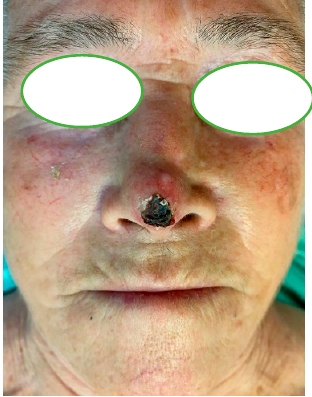
Figure 3. Recurrent basal cell carcinoma—15 years after surgery.